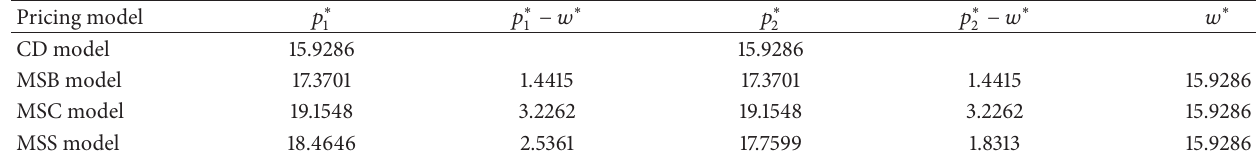
Table 4: Optimal retail prices and wholesale price under different pricing models. Pricing